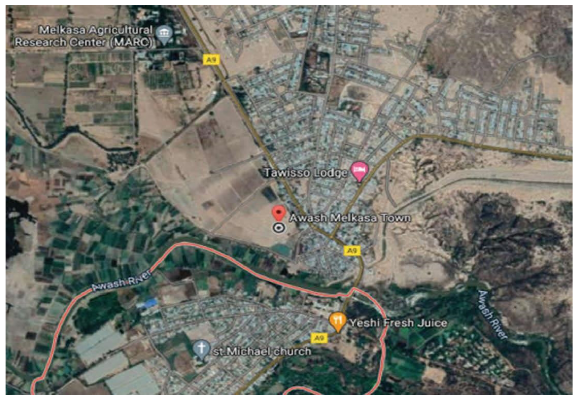
Figure 1: Map study area with the location of the test pit (Awash Melkasa-Google Maps, n.sd.). Table 1: Global coordinates of the test pits’ location.